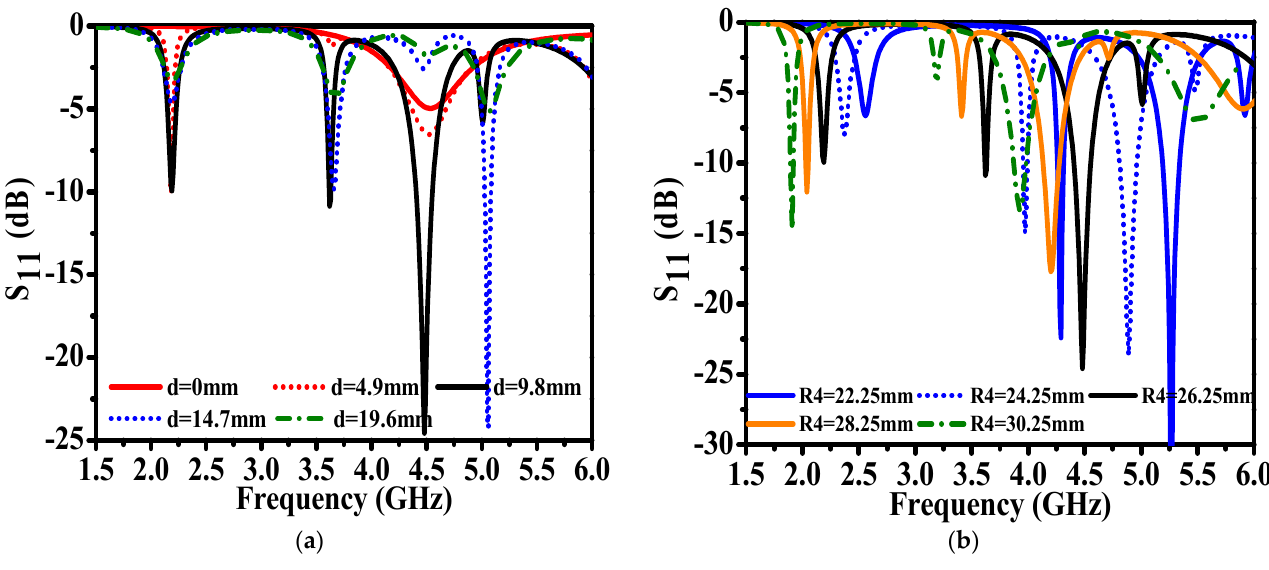
Figure 3. The effect of different parameters on simulate d S 11 of Ant. 1. ( a ) d; ( b ) R4.